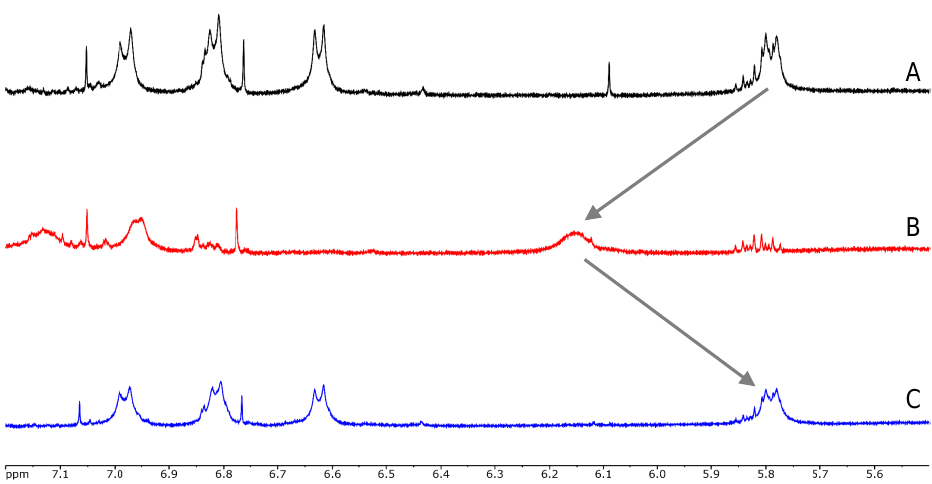
Figure 3. A proton nuclear magnetic resonance ( 1 H-NMR) spectra (aromatic region) of ins -SP-PPE before ( A , black line) and after adding TFA ( B , 0.04 M, red line) and then TEA ( C , 0.08 M, blue line). Gray allows indicate the shift of signals deriving from vinyl protons of SP and MCH + .